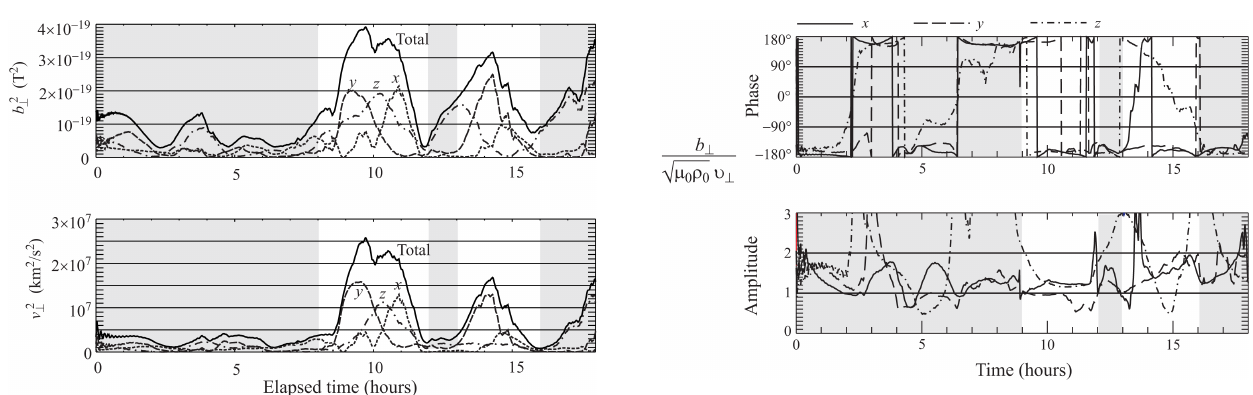
Figure 4. GSM components of b ⊥ and v ⊥ . Time is measured from 01:31 on 7 June 2000. The unshaded portions of the diagram indi- cate the peaks in wave energy density.